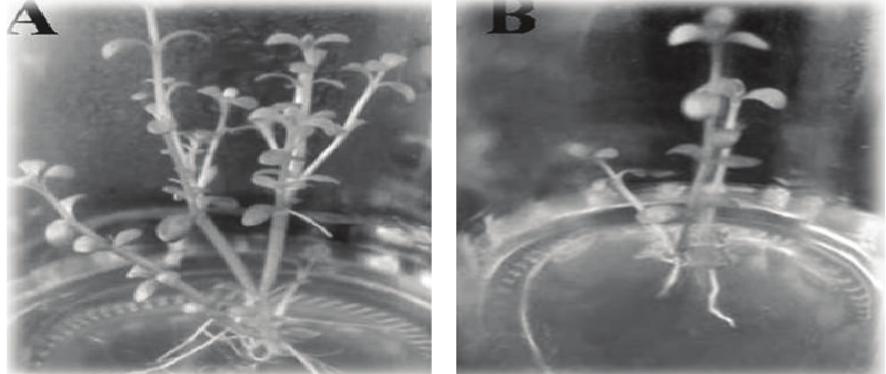
Figure 3: Inoculation of endophytic S. aquimarina SjAM16103 in B. monnieri ( in vitro ). (A) S. aquimarina SjAM16103 inoculated explants; (B) control explants.